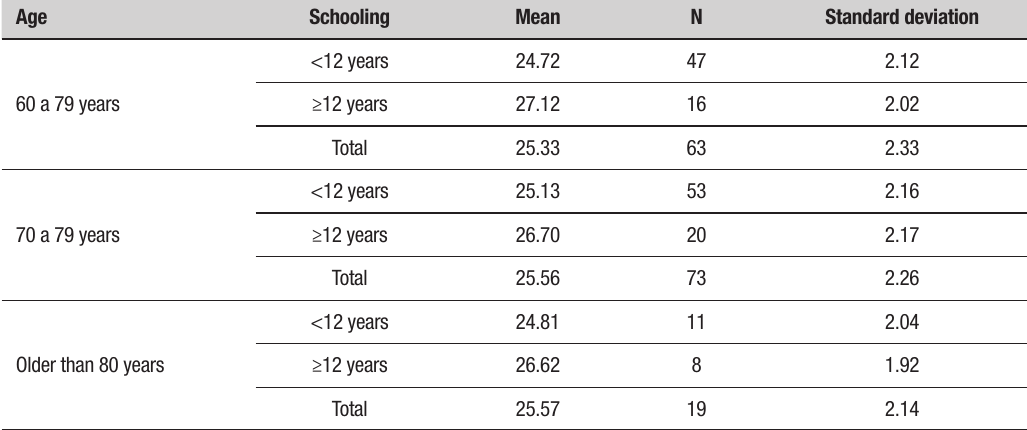
Table 3. MoCA-A control scores stratified by age and schooling